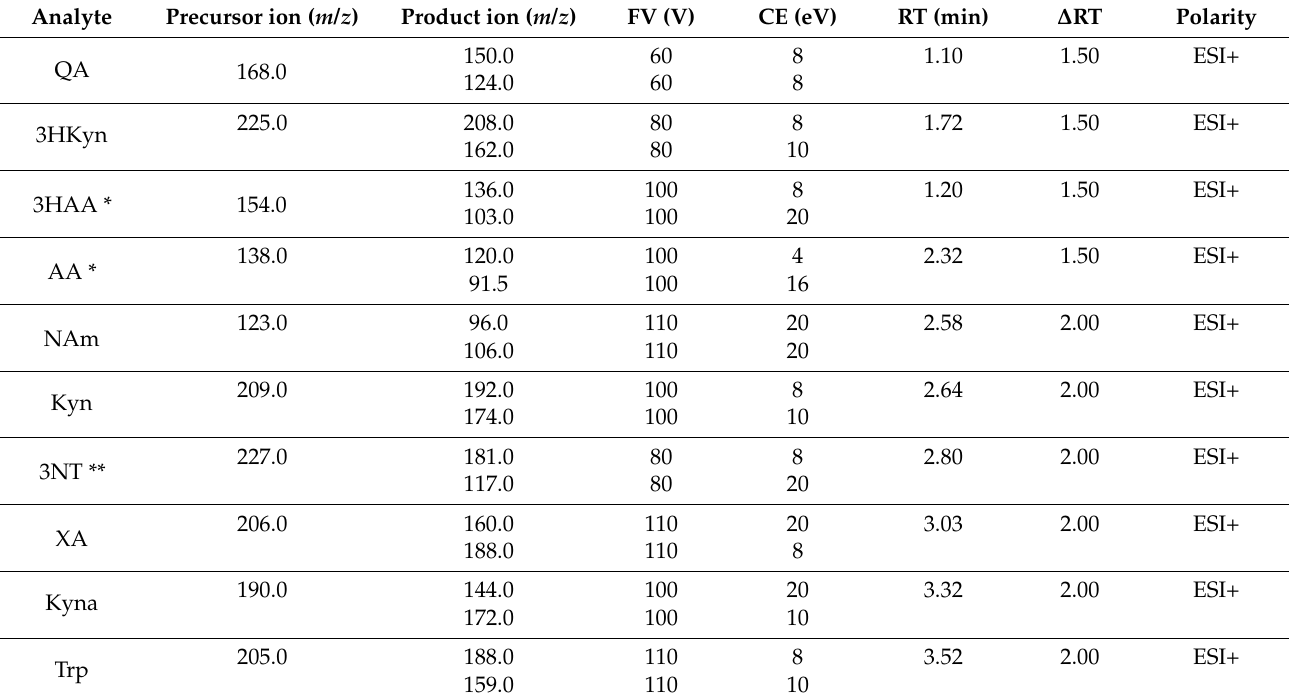
Table 1. Selected DMRM transitions and instrument settings.